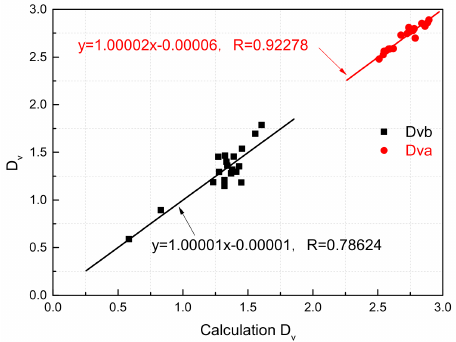
Figure 9. Comparison between the T 2 curve derived fractal dimension and the calculated fractal dimension by Equations (15) and